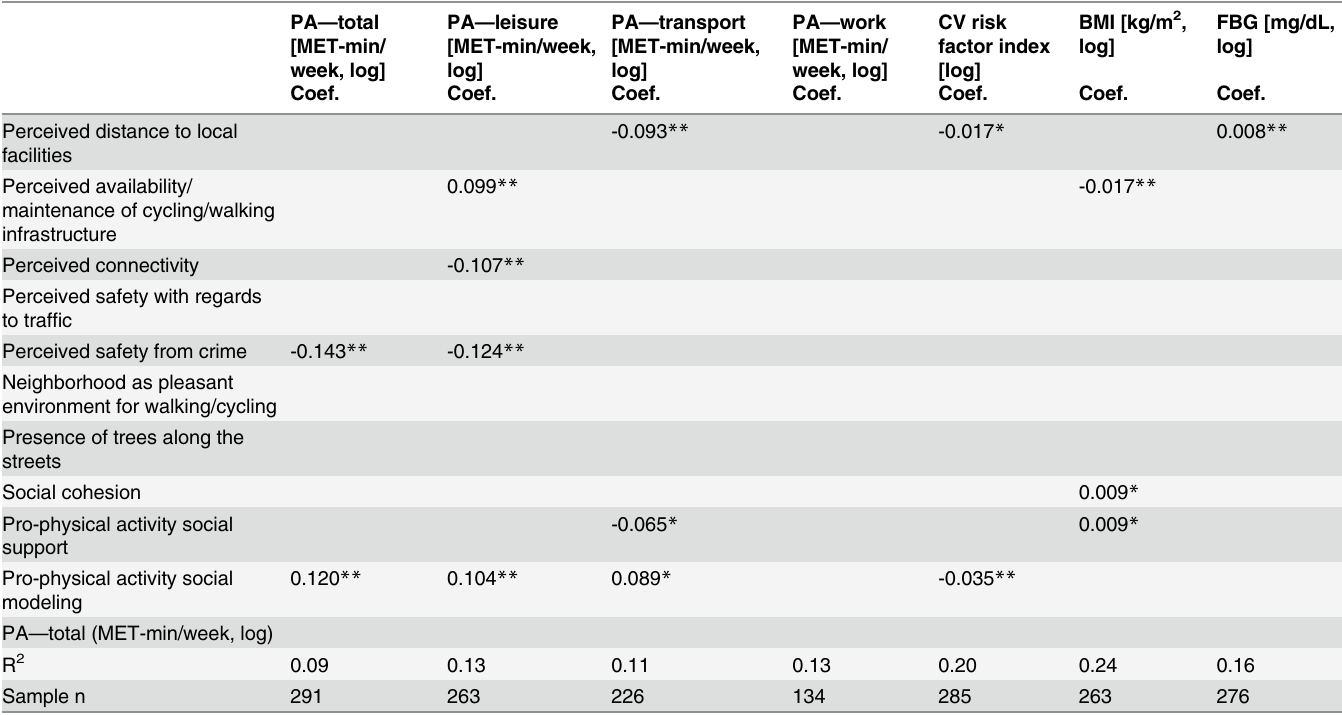
Table 3. Cardiovascular risk factors/behaviors by built and social residential characteristics as well as individual characteristics — final stepwise multiple linear regression model results — Women a